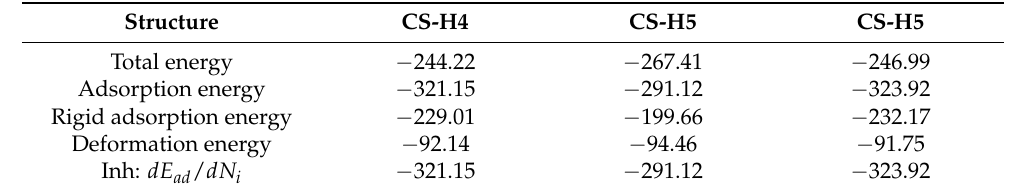
Table 2. Simulation results (total energy, adsorption energy, rigid absorption energy, and deformation energies) in vacuum (Fouda et al., 2021) [45].